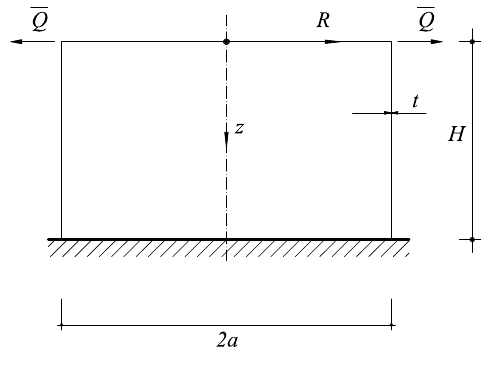
Figure 4. Cantilever cylindrical shell under tip load. Cross section.